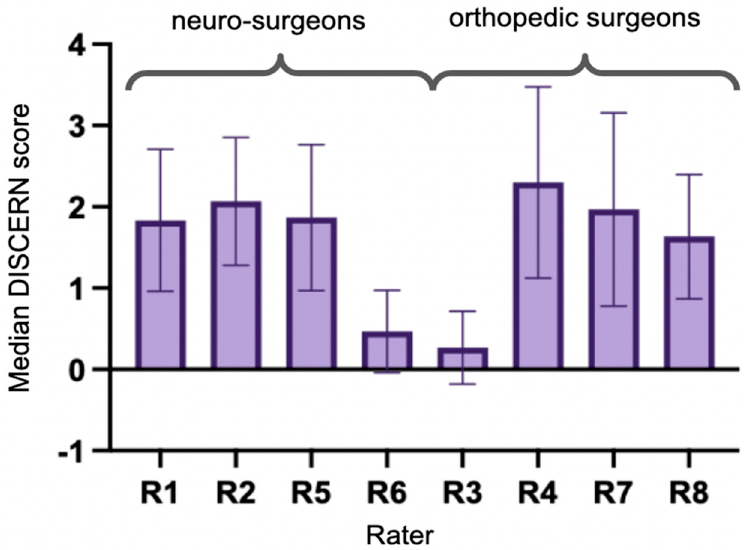
Figure 3. Median DISCERN Scores for each rater (R1-8). R6 and R3 assigned significantly lower DISCERN scores than the others.